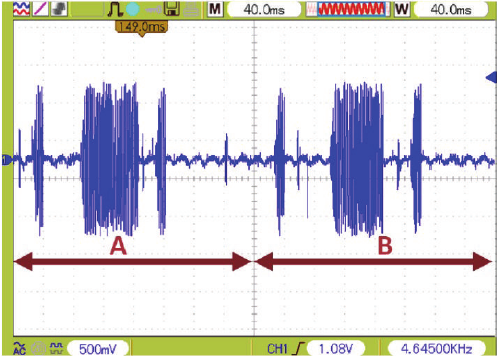
Figure 11: Master request slave response FSK data